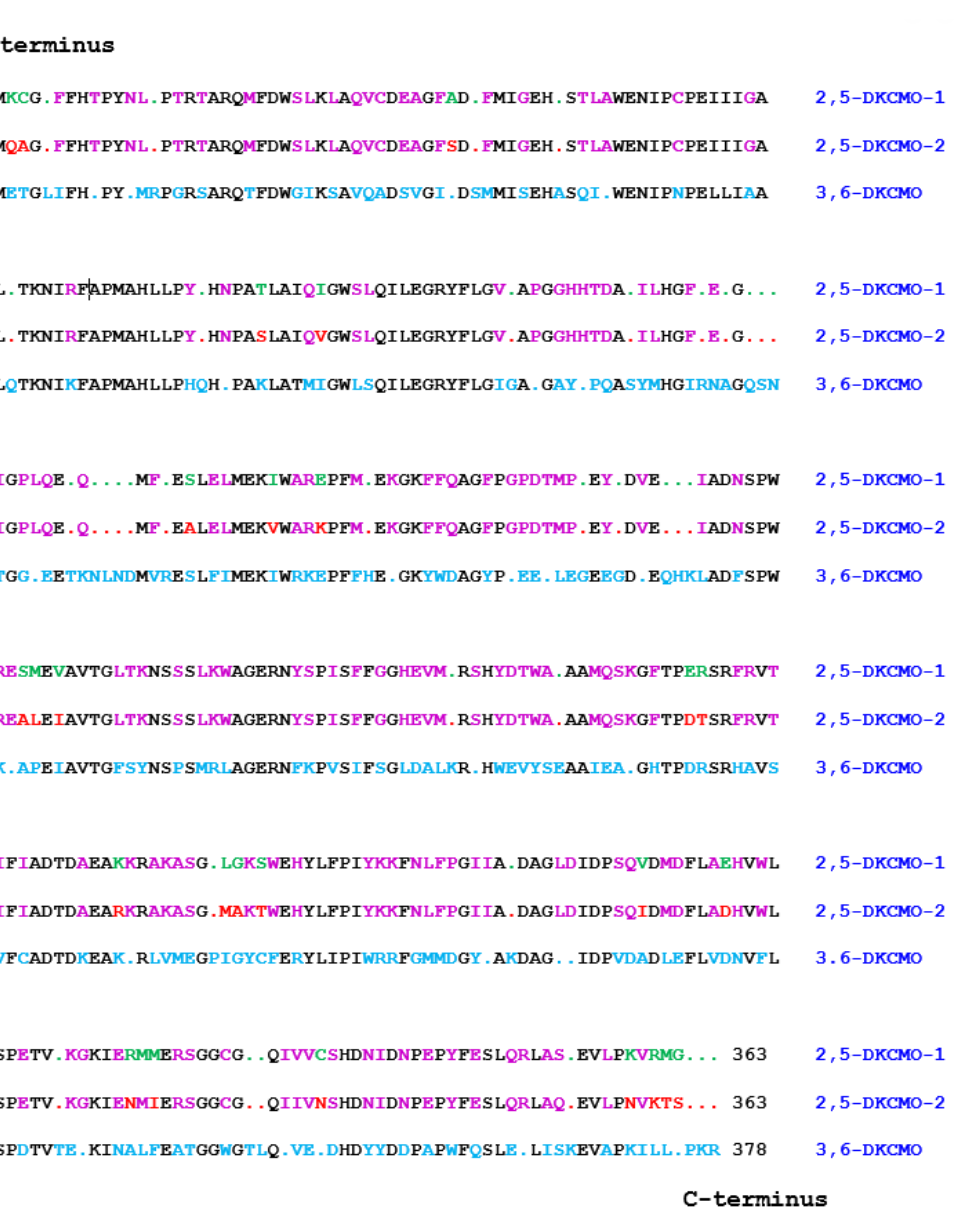
Figure 8. Protein sequence alignment of the oxygenating subunits of 2,5-DKCMO-1 ( orf-4 , camE 25- ,) 2,5-DKCMO-2 ( orf-22 , camE 25-2 ) and 3,6-DKCMO ( orf-19 , camE 36 ). Amino acid residues: common to 2,5-DKCMO-1, 2,5-DKCMO-2, and 3,6-DKCMO = black ; common to 2,5-DKCMO-1 and 2,5-DKCM-2 = magenta ; exclusive to 2,5-DKCMO-1 = green ; exclusive to 2,5-DKCMO-2 = red ; exclusive to 3,6-DKCMO = blue